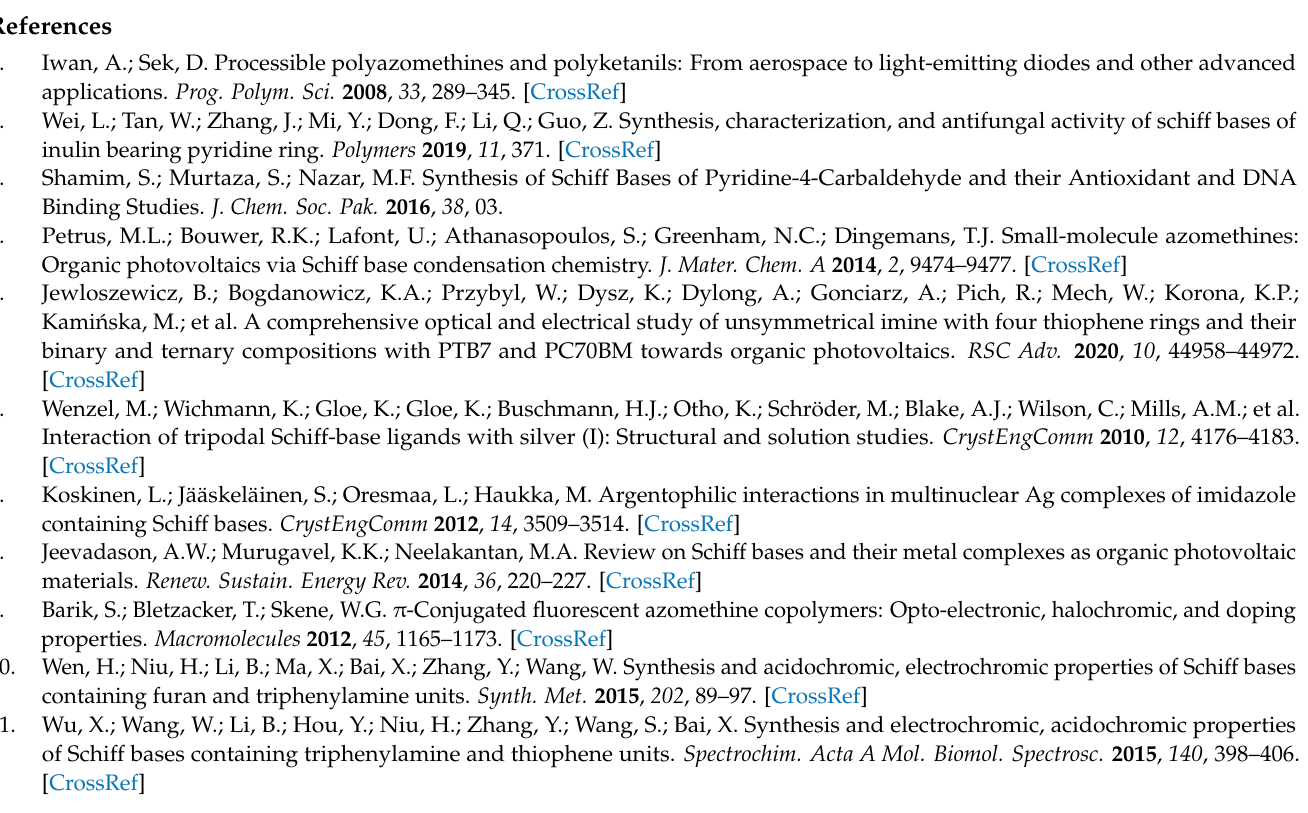
Figure S6: Theoretical scaled FT-IR spectra of PPL9 in the range in the range 3500–50 cm − 1 . Figure S7: Experimental 1 H NMR spectra of crystalline PPL9. Figure S8: Simulated 1 H NMR spectrum of trans- PPL9 according to GIAO method at DFT/B3LYP/6-311+G(2d,p) level. Numbering of trans-PPL9 (H + doped) (a) 1 H NMR spectrum of trans-PPL9 (b) 1 H NMR spectrum of H + doped trans-PPL9 (c). Figure S9: TGA of PPL9. Table S1: The bond lengths (Å) and bond angles ( ◦ ), with s.u.s. in parentheses, determined for PPL9, by X-ray diffraction and the corresponding theoretical parameters, calculated for trans-PPL9 by B3LYP method 6-31+G (d,p) basis set. Table S2: A statement of the theoretical harmonic wavenumbers ( ν a , ν b , cm − 1 ), infrared intensities (A IR , km mol cm − 1 ), Raman scattering activities (S R , A 4 amu cm − 1 ) and Raman intensities (IR) calculated for PPL9 by the B3LYP method with 6-31+G (d,p) basis